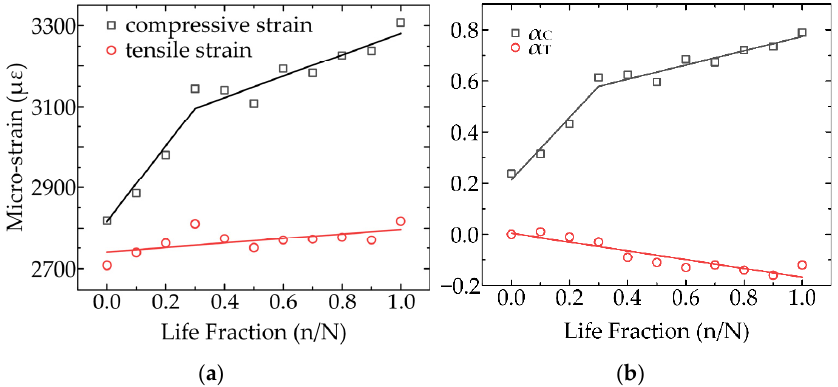
Figure 8. The evolution of the average strain ( a ) and model parameters ( b ) as a function of fatigue. The upper and lower strain relationships of the specimens under different degrees of fatigue were obtained experimentally. Eleven groups of strain values were substituted in the two-mode nonlinear model developed in this study to obtain α C ( t ) and α T ( t ) under different degrees of fatigue, as shown in Figure 8b. α C ( t ) exhibited a similar trend to the compression strain on the upper side of the specimen, while α T ( t ) exhibited a downward trend. On this basis, the dynamic evolution process of the modulus under fatigue load was obtained, as shown in Figure 9.